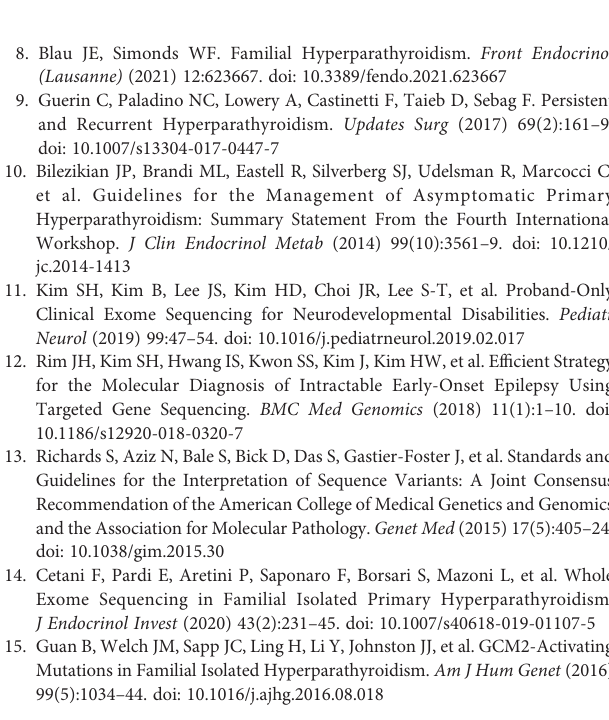
Supplementary Table 1 | Gene panel list: targeted gene sequencing. Genes which are included in our candidate gene list ( Supplementary Table 2 ) are shown in yellow box. Supplementary Table 2 | List of candidate genes related to parathyroid diseases. Supplementary Table 4 | The criteria used for each pathogenic and likely pathogenic